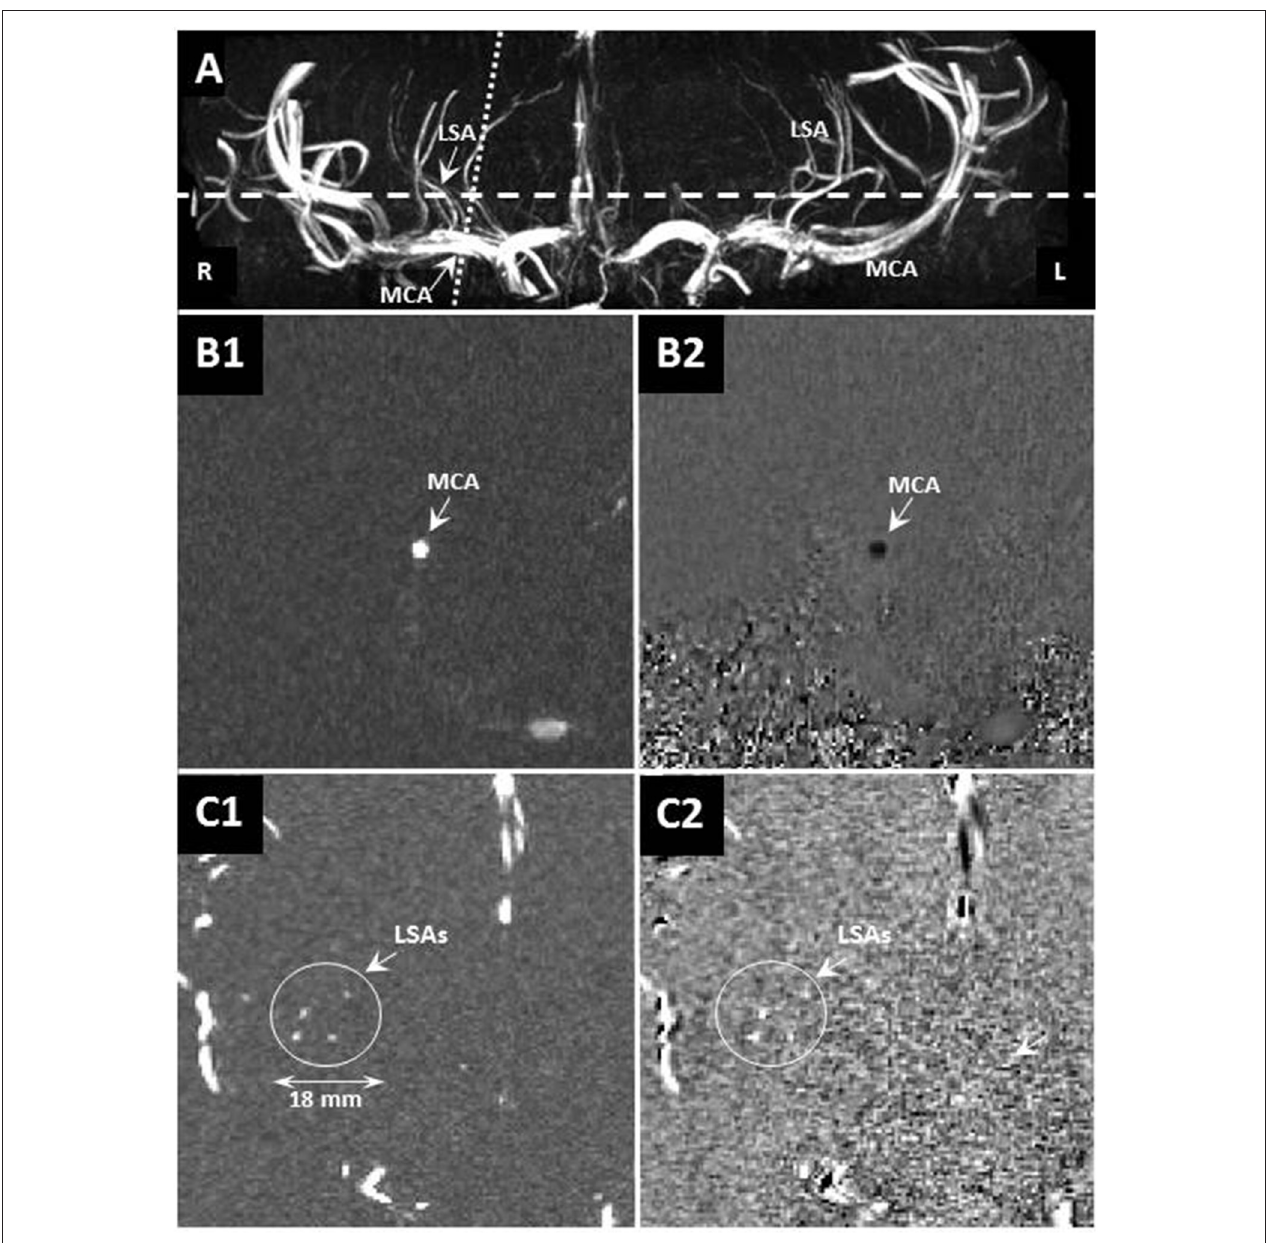
FIGURE 1 | (A) Example maximum-intensity-projection of a time-of-flight volume image showing the geometrical planning of the velocity-sensitized slices of the flow waveform measurement in the LSA (dashed line) and MCA (dotted line). (B) The velocity-sensitized slices showing the magnitude (left: B1,C1 ) and phase (right: B2,C2 ) of the MCA (top: B1,B2 ) and LSA (bottom: C1,C2 ). The scale is indicated in the bottom left.